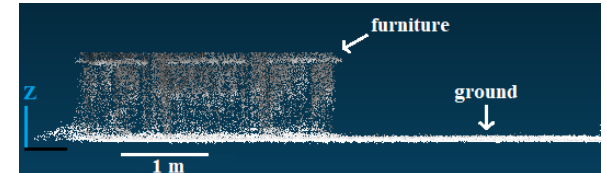
Figure 8: Vertical slice in the ZEB-REVO point cloud